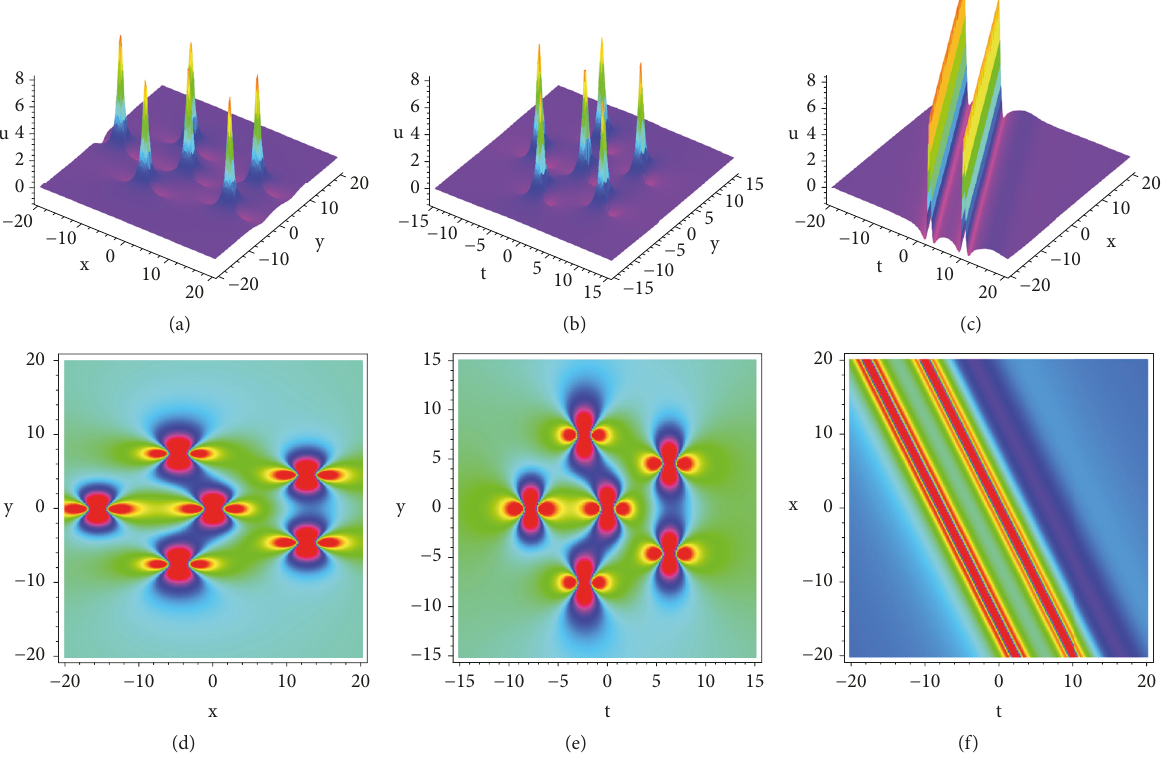
Figure 7: Plots (colored online) of 6-lump wave 𝑢 (17) with 𝑚 = 2, 𝑎 = 𝑏 = −2 , 𝛼 = 8 × 10 5 , 𝛽 = 10 × 10 5 . (a) Perspective view of the wave 𝑢(𝑥,𝑦, 0) , (b) perspectiveview of the wave 𝑢(0, 𝑦,𝑡) , (c) perspective view of the wave 𝑢(𝑥, 0,𝑡) , (d) overhead view of the wave (a), (e) overhead view of the wave (b), and (f) overhead view of the wave